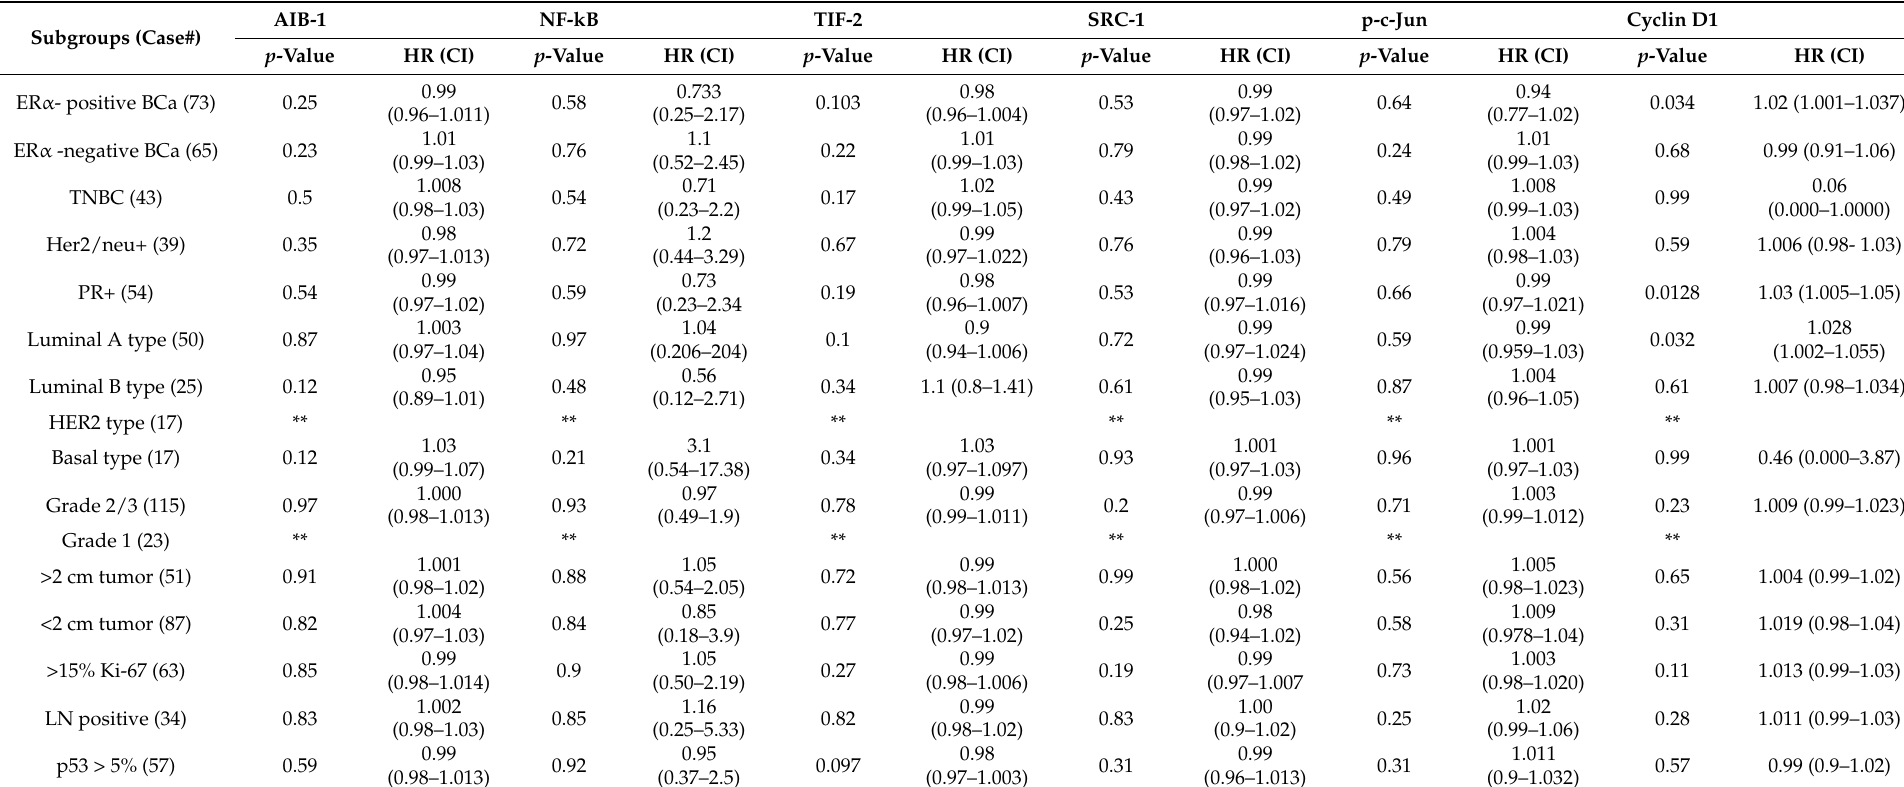
Table 6. Cox univariate overall survival analysis of coactivators in breast cancer subtypes and